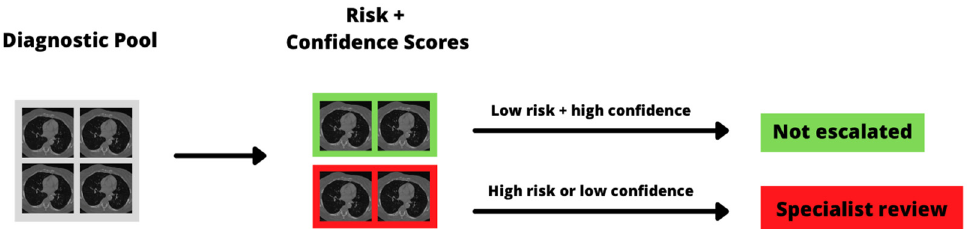
Figure 4. Example diagnostic triage pipeline. The AI model assigns a risk group to each examina- tion, as well as a confidence estimate, and scans that are either high risk or have low diagnostic confidence are escalated for specialist review. CT images taken from the public LUNGx dataset [97].